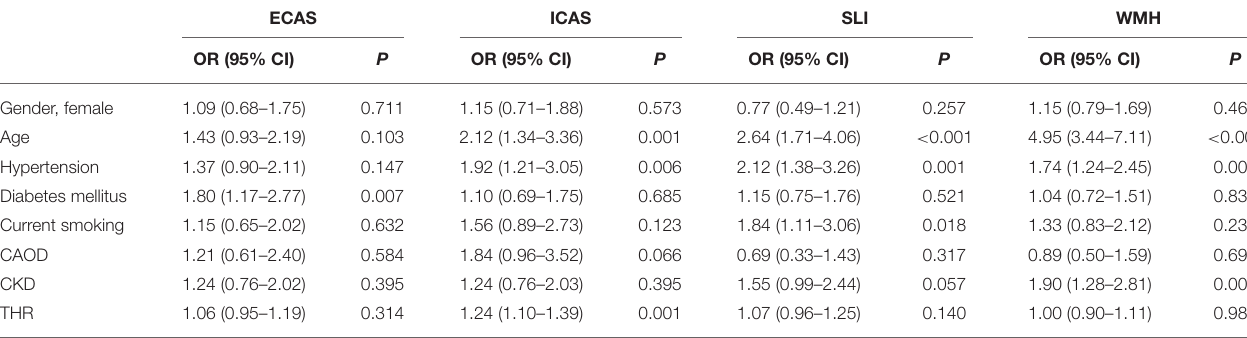
TABLE 3 | Logistic regression analysis of vascular risk factors for ECAS, ICAS, SLI, and WMH.